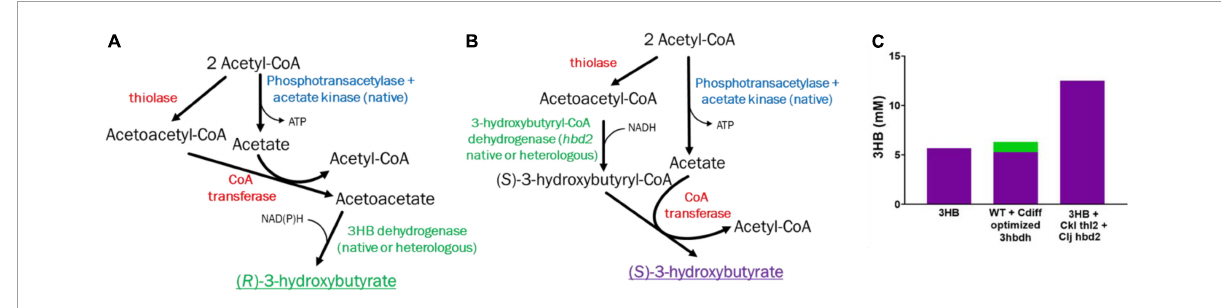
FIGURE5 ( R ) vs. ( S ) 3HB Pathways and quantification. (A) The R -3HB pathway (B) The S -3HB pathway. Red indicates heterologous genes, blue native genes, green native or heterologous. (C) R (in green) vs. S (in purple) 3HB distribution from heterotrophic fermentation samples using HPLC and enzymatic